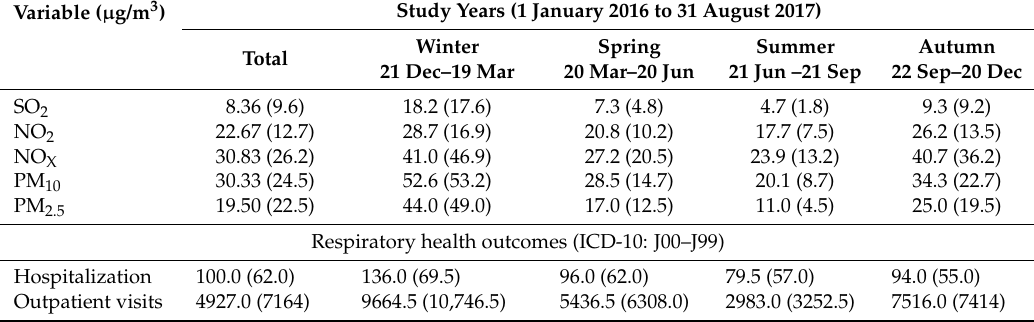
Variable ( µ g/m 3